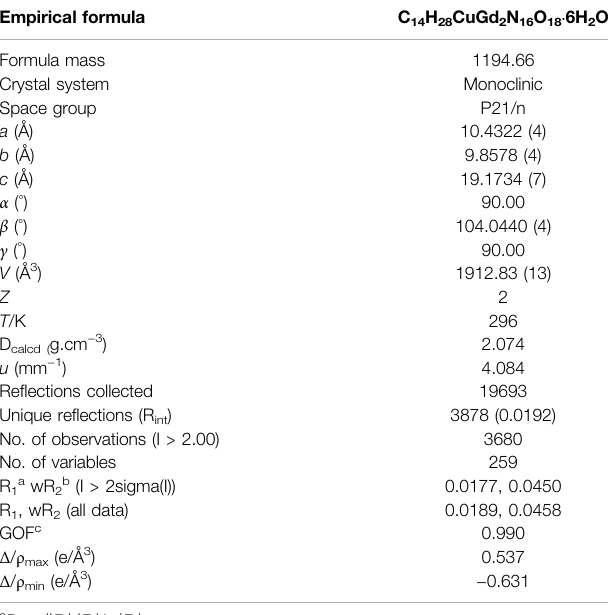
TABLE 1 | Crystallographic parameters of [Gd 2 Cu(L) 2 H 2 O 10 ] · 6H 2